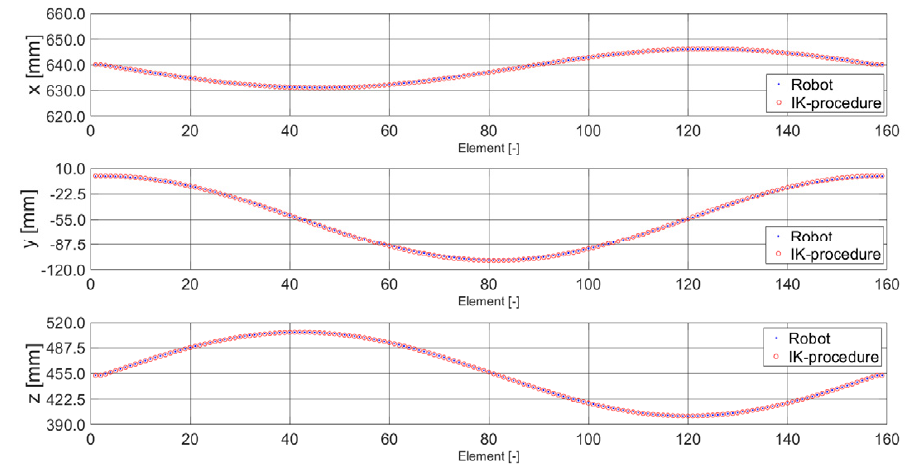
Figure 14. Circle in the Y-Z plane: X-, Y-, Z-axes Robot vs. IK procedure.